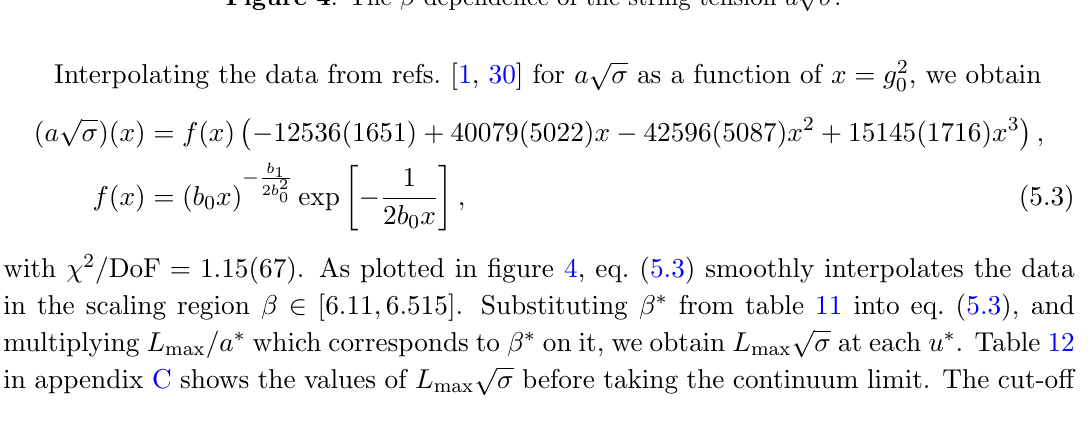
Figure 4 . The (cid:12) dependence of the string tension a